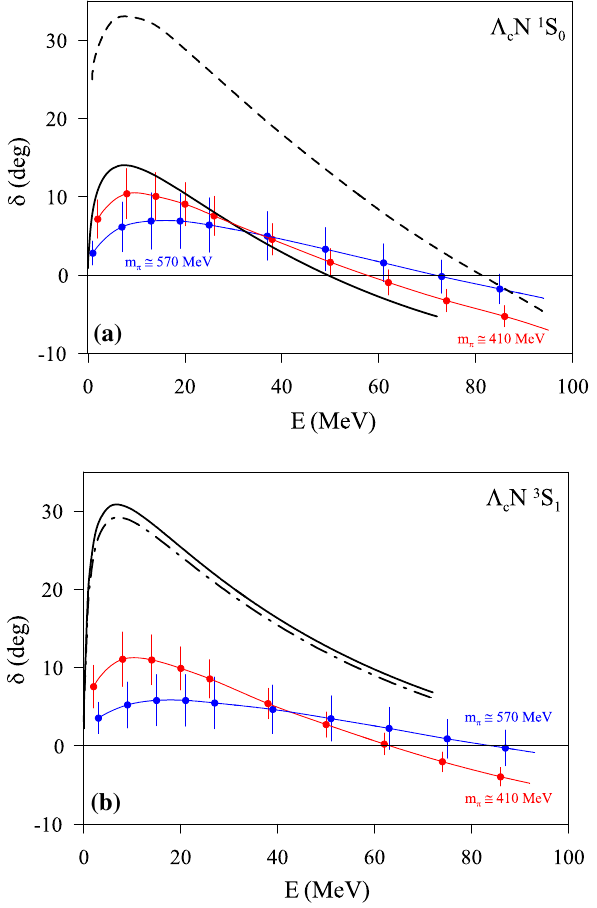
Fig. 2 a Phase shifts for the (cid:2) c N 1 S 0 partial wave as a function of the c.m. kinetic energy. The black solid line stands for the prediction of the CQM. The black dashed line corresponds to the QDCSM results of Ref. [28]. The blue (red) filled circles represent the results of the HAL QCD Collaboration [44] at m π = 570 ( 410 ) MeV. The vertical line at eachpointrepresentsthestatisticalerrorofthelatticeQCDsimulations. The solid blue and red lines are just a guide to the eye. b Phase shifts for the (cid:2) c N 3 S 1 partial wave as a function of the c.m. kinetic energy. The black solid line stands for the prediction of the CQM. The black dashed-dotted line represents the CQM phase shifts without channel coupling. The blue (red) filled circles represent the results of the HAL QCD Collaboration [44] at m π = 570 ( 410 ) MeV. The vertical line at eachpointrepresentsthestatisticalerrorofthelatticeQCDsimulations. The solid blue and red lines are just a guide to the eye